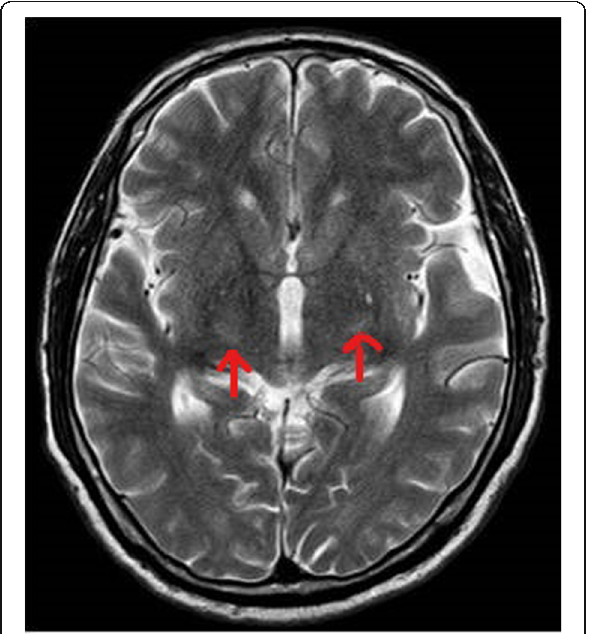
Fig. 2 Axial T2 WI at the level of ganglio-thalamic region showing hyperintensity in posterior limbs of bilateral internal capsules (red arrows)